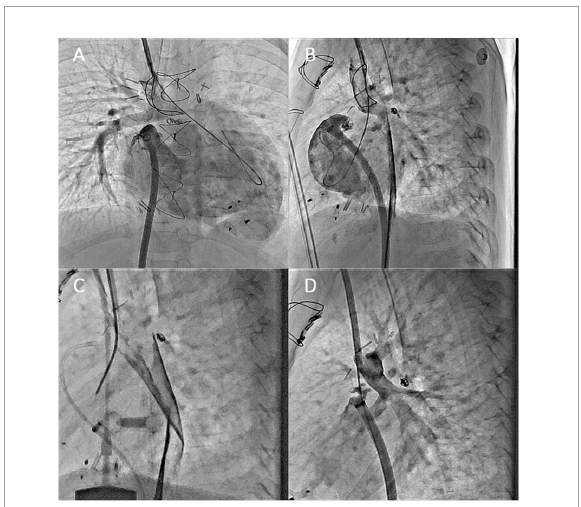
FIGURE8 Angiographic images from 5-years-old boy who underwent transcatheter Fontan completion. (A,B) Simultaneous frontal and lateral injections of the right atrium and Glenn showing the distance between the two circuits. Please notice the clips at SVC and IVC levels; (C) lateral view of the connection created with a needle between Glenn and RA; (D) lateral angiogram after perforation showing no significant bleeding and SVC to RA